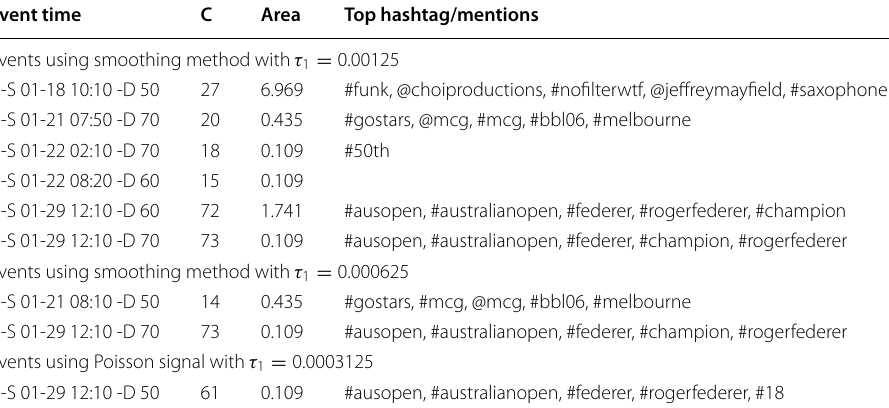
Table 5 Sample detected events for different Poisson signal thresholds Event time C Area Top hashtag/mentions Events using smoothing method with τ 1 = 0.00125